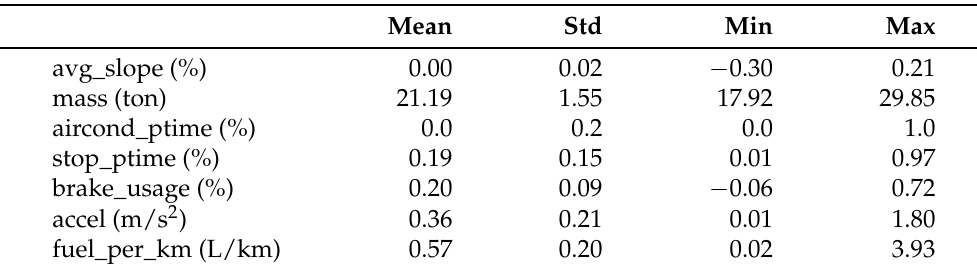
Table 1. Statistics of the data set features: mean, std (standard deviation), and minimum and maximum feature